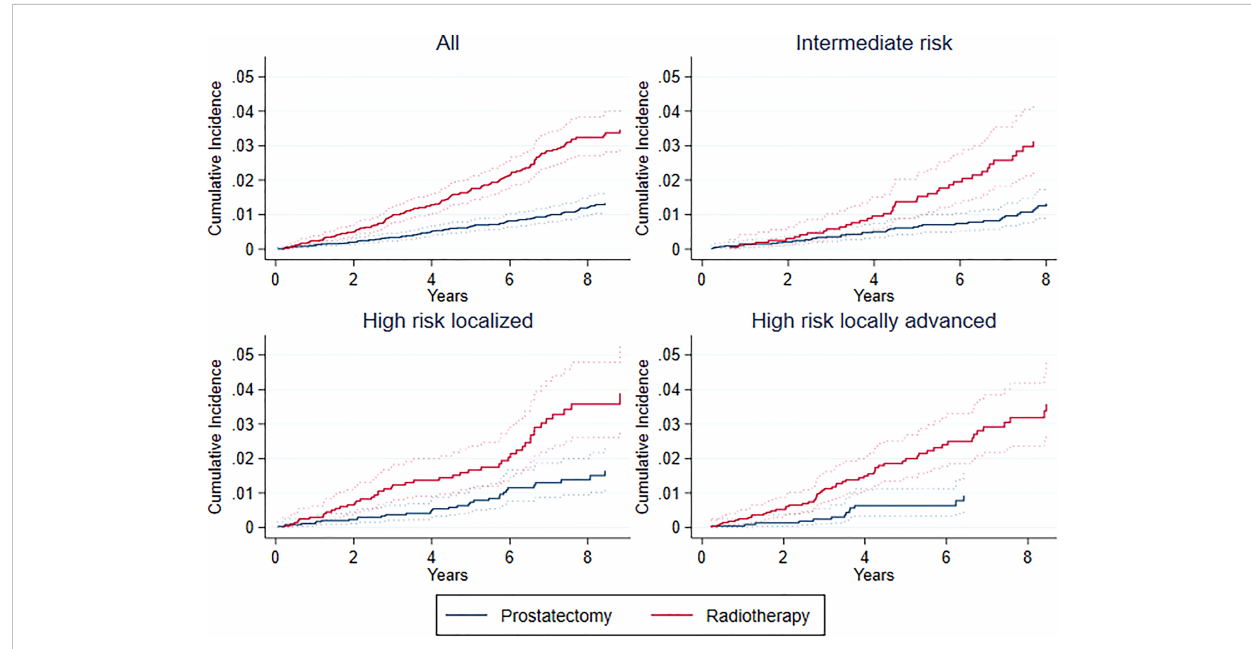
FIGURE 4 Cumulative incidence of cardiovascular-speci fi c death in total cohort and by risk groups. Risk groups de fi ned according to the European Association of Urology (EAU) Guidelines: 1) intermediate risk: PSA 10-20 ng/ml or Gleason score 7 or cT2b; 2) high risk localized: PSA >20 ng/ml or Gleason score >7 or cT2c; 3) high risk locally advanced: cT3-4 or N1 with any PSA and Gleason score. Years correspond to years since date of radical prostatectomy or start date of de fi nitive